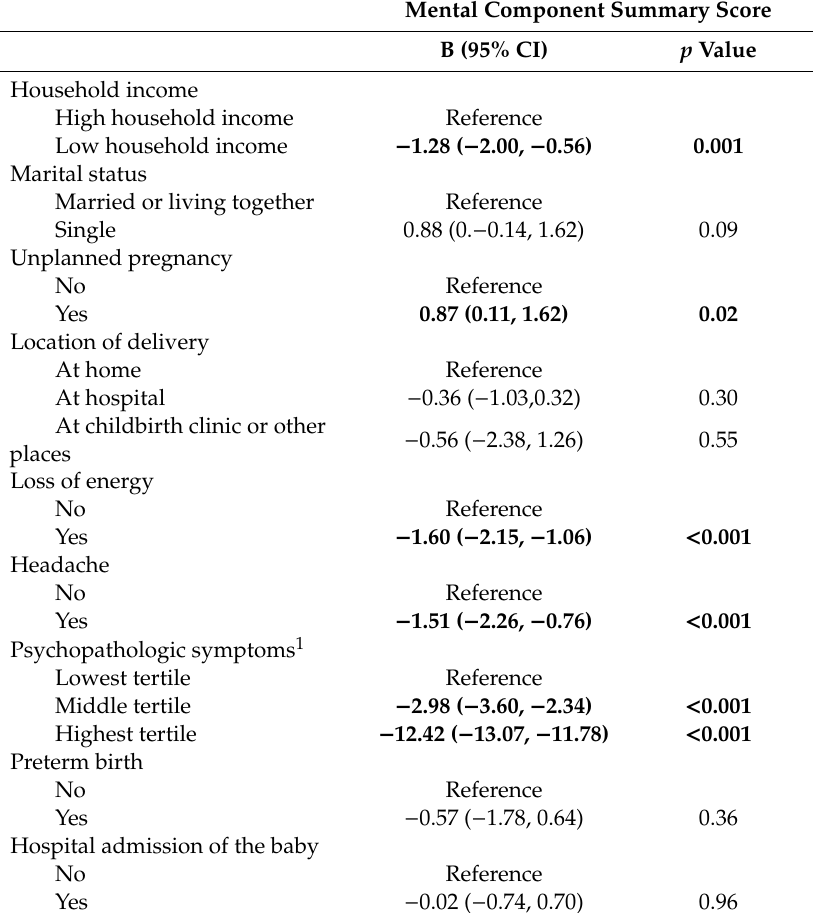
Table 3 is based on the imputed dataset. Values represent betas with 95% CIs (confidence intervals) and p values derived from multiple linear regression analyses. Bold print indicates the statistical significance. The significance level is p < 0.05. 1 Maternal psychopathology was measured by the brief symptom